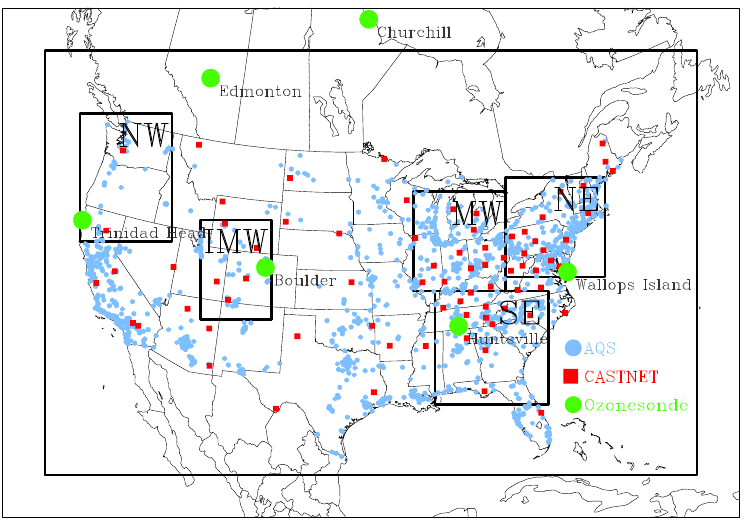
Figure 2. Map of the 12km CMAQ modeling domain, the five analysis domains, and the location of the AQS and CASTNET surface O 3 monitoring stations and ozonesonde launch sites. Table 3. Seasonal model performance for MDA8 ozone at AQS sites as measured by normalized mean bias (NMB), normalized mean error (NME), and correlation coefficient for the BASE simulations for all sites and the five analysis regions is shown in Fig. 2. The metrics were computed at each AQS site for each season, and the median metric across all sites in a given region and season is shown in this table. The fonts used in the table are based on the model evaluation goals and acceptability criteria proposed by Emery et al. (2017). Cells in normal font indicate regions and seasons where model performance meets the goal for a given metric (NMB < ± 5%, NME < 15%, and R > 0.75), cells in italics indicate regions and seasons where model performance meets the acceptability criterion but not the goal ( ± 5% < NMB < ± 15%, 15% < NME < 25%, and 0.5 <R < 0.75), and cells in bold font indicate regions and seasons where neither the goal nor the acceptability criterion are met (NMB ≥± 15%, NME ≥ 25%, and R ≤